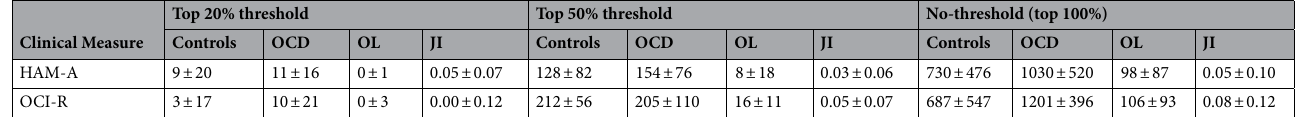
Table 3. Overlap (Mean ± SD ) of weighted connections between OCD patients and controls estimated across the bootstrapped samples for three threshold conditions. Results were only presented for HAM-A and OCI-R. The number of overlaps (OL) is negligible compared to the total number of connections, as reflected by smaller values of the Jaccard index (JI). Each connection was given a weight based on the number of times it appeared in the leave-one-out bootstrap scheme for that group. Thresholding (as specified) was performed to select the connections that contributed most to the prediction. The overlap represents the number of connections that were common between the two groups. HAM-A Hamilton Anxiety Rating Scale, OCI-R Obsessive– Compulsive Inventory (Revised), SD standard deviation, OL overlap, JI Jaccard